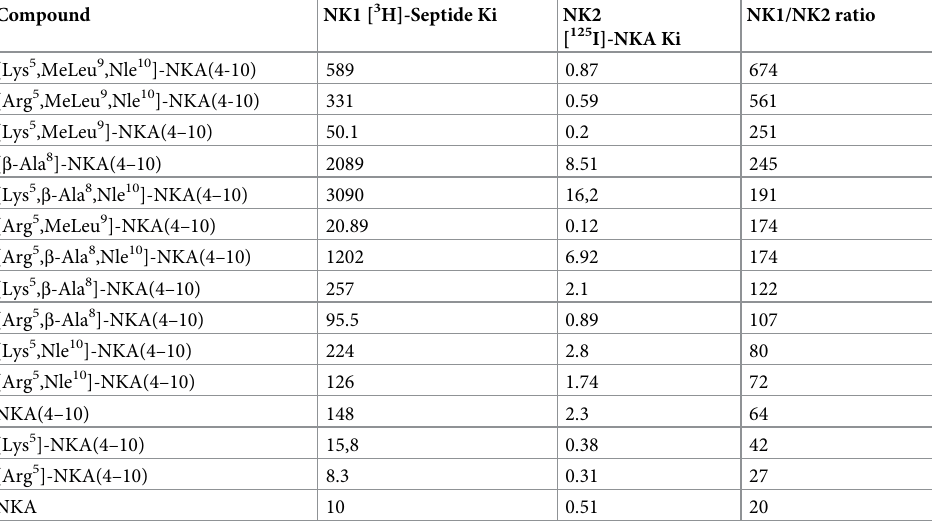
Table 4. Ratio of Ki values (in nM) for displacement of [ 125 I]-NKA and [ 3 H]-Septide binding. Compound